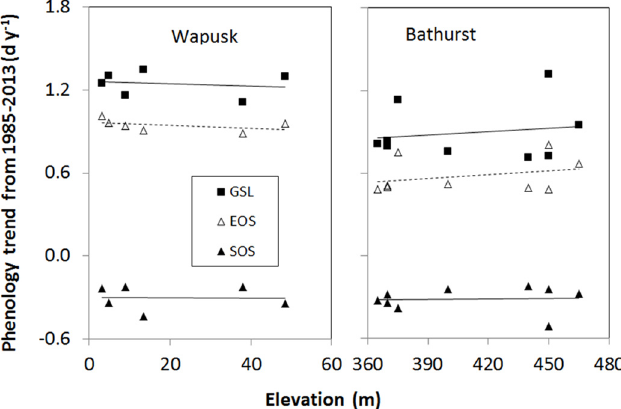
Figure 8. Relationships between SOS, EOS, or GSL trends during 1985–2013 and elevation over the two flat study areas: the Wapusk National Park and the Bathurst caribou summer range and calving ground. Statistics for these relationships are listed in Table ground. Statistics for these relationships are listed in Table 4.